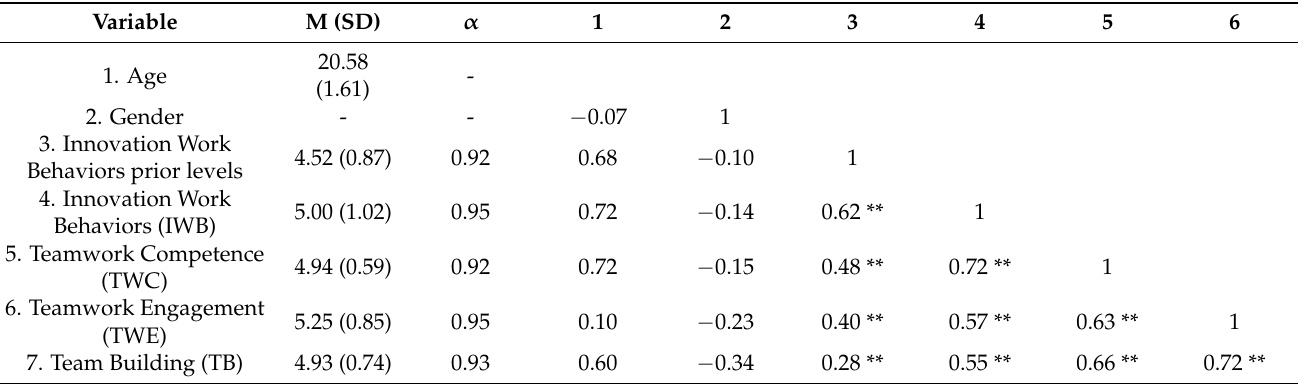
Table 3. Descriptive, reliability and correlational